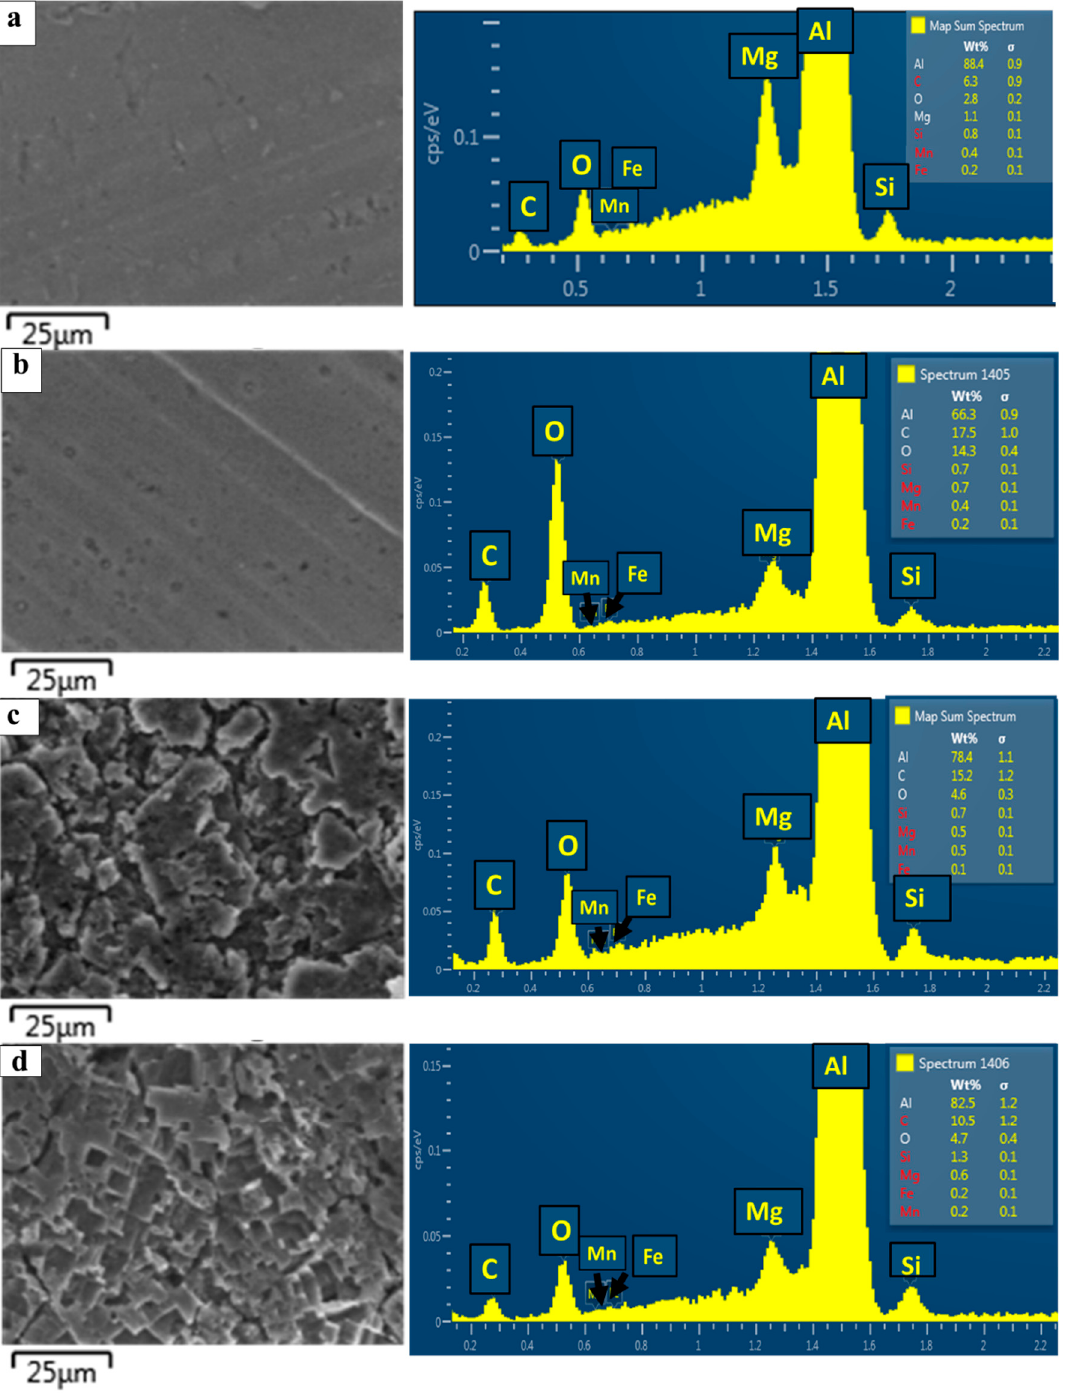
Figure 3. EDS spectra of A_R ( a ), A_WS sample ( b ), A_NS sample ( c ), and A_FS sample ( d ).